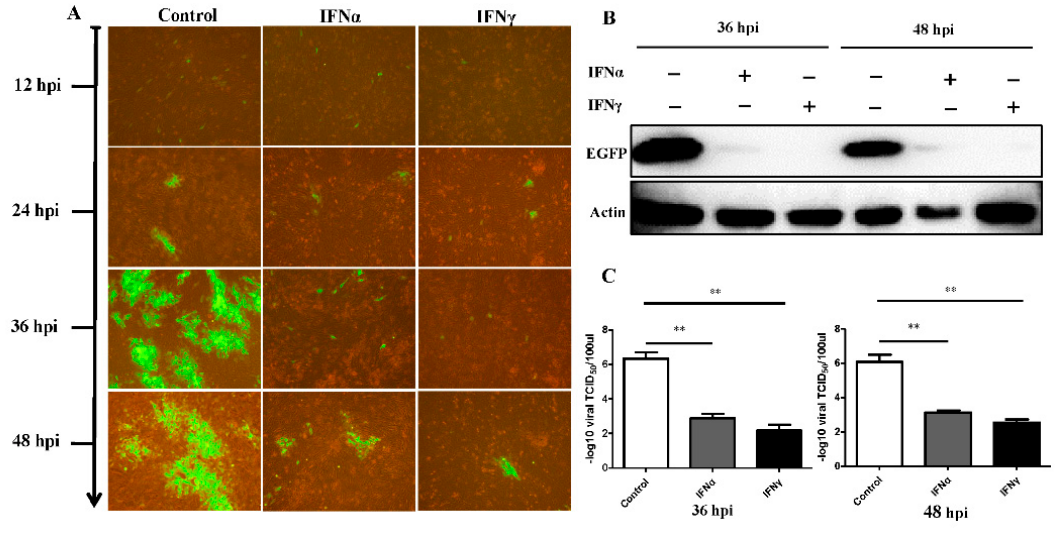
Figure 2. Duck plague virus (DPV) was significantly inhibited by the goose IFN α and IFN γ . ( A ) duck embryo fibroblast (DEF) cells were pre-treated with indicated interferon protein and negative control (60 µg/well). The the supernatant collected from the BHK21 cells transfected with the empty pcDNA3.1 (+) plasmids is used to pre-treat GEFs as the negative control. 12 h later, the cells were then infected by DPV-EGFP (4 × 10 4 TCID 50 /well). Enhanced green fluorescent protein (EGFP) expression, an indication of DPV replication, is shown by green fluorescence when examined by fluorescence microscopy. Magnification 400×; ( B ) At 36 hpi and 48 hpi, the medium was collected for the further Western Blotting analysis. The primary antibodies were rabbit-anti EGFP (1:2000) and mouse-anti actin (1:2000); secondary antibodies were the goat-anti rabbit and goat-anti mouse antibodies conjugated to Horseradish peroxidase (HRP); ( C ) Viral titer reduction assay. Cells were treated with indicated IFN α , IFN γ , or left control for 12 h before infection with DPV. After 36 h and 48 h, the samples in the four wells used for each treatment were frozen and thawed out repeatedly and pooled, and the viral yield in the culture medium was determined by the tissue culture infectious dose 50 (TCID 50) method.